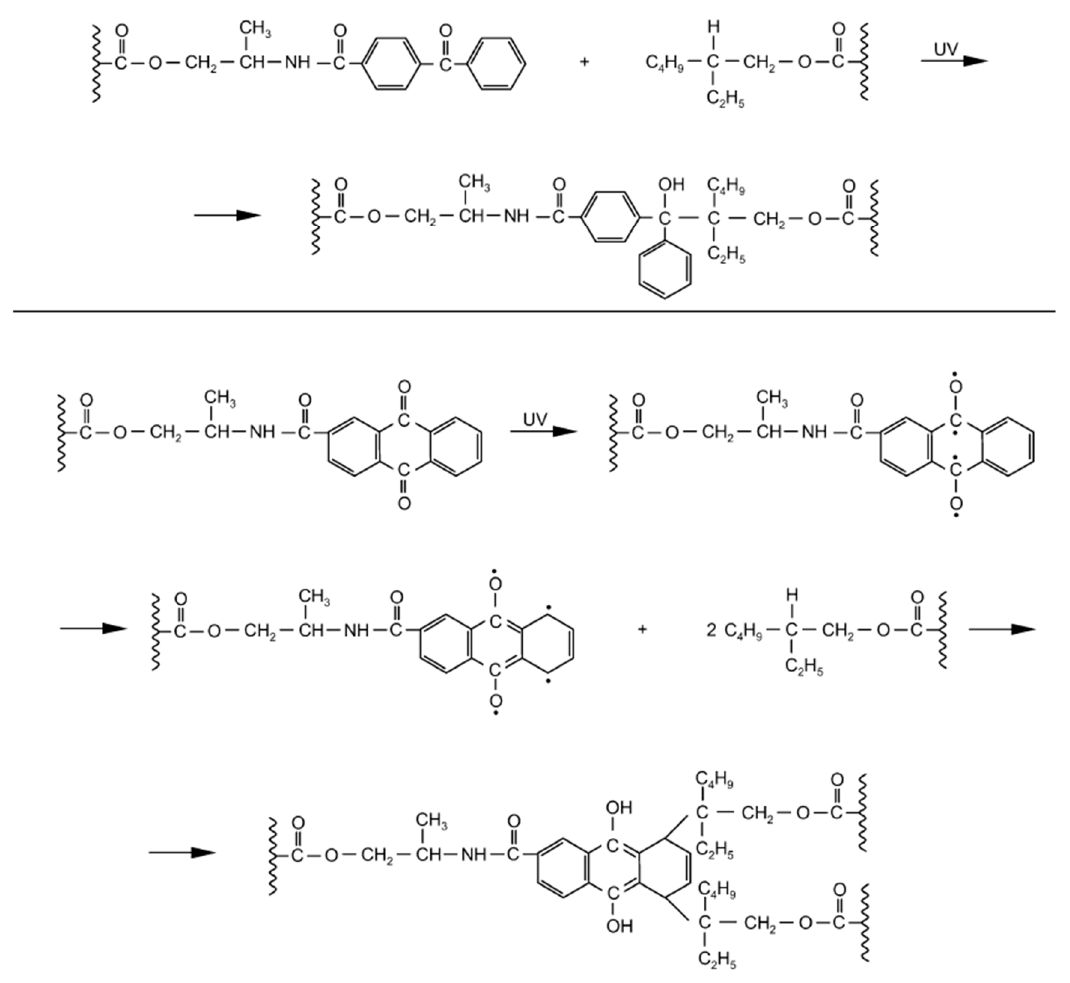
Figure 12. UV-initiated cross-linking of acrylic PSAs in the presence of additionable photoinitiators incorporated into the polymer backbone .